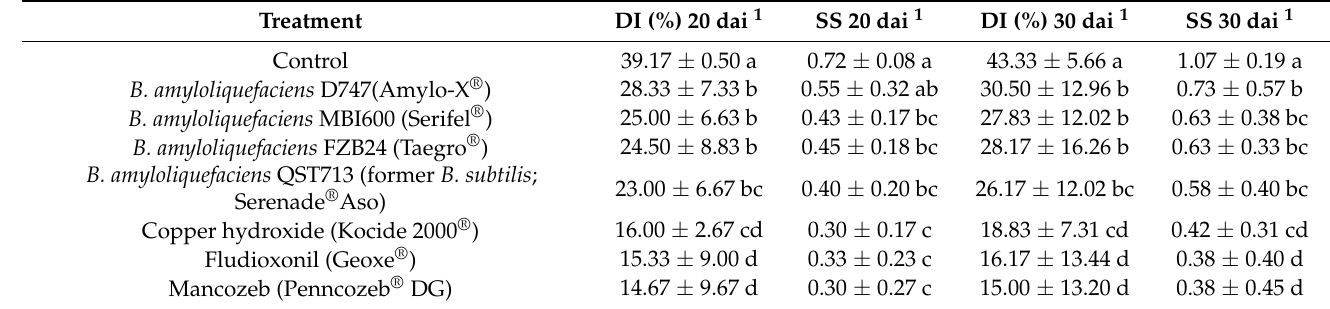
Table 6. Post-hoc analysis on main effects of treatments in reducing artificial infections caused by Plenodomus tracheiphilus